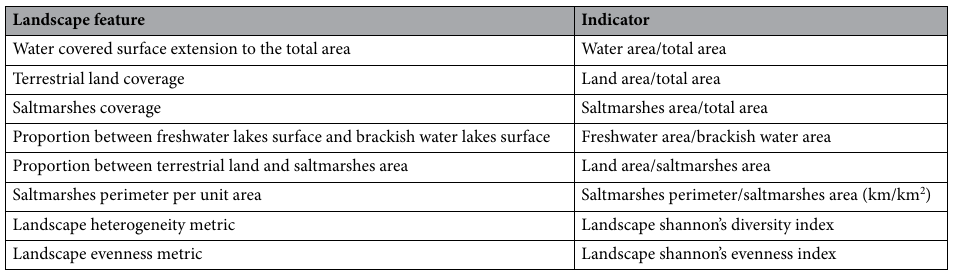
Table 3. Landscape indicators adopted in the